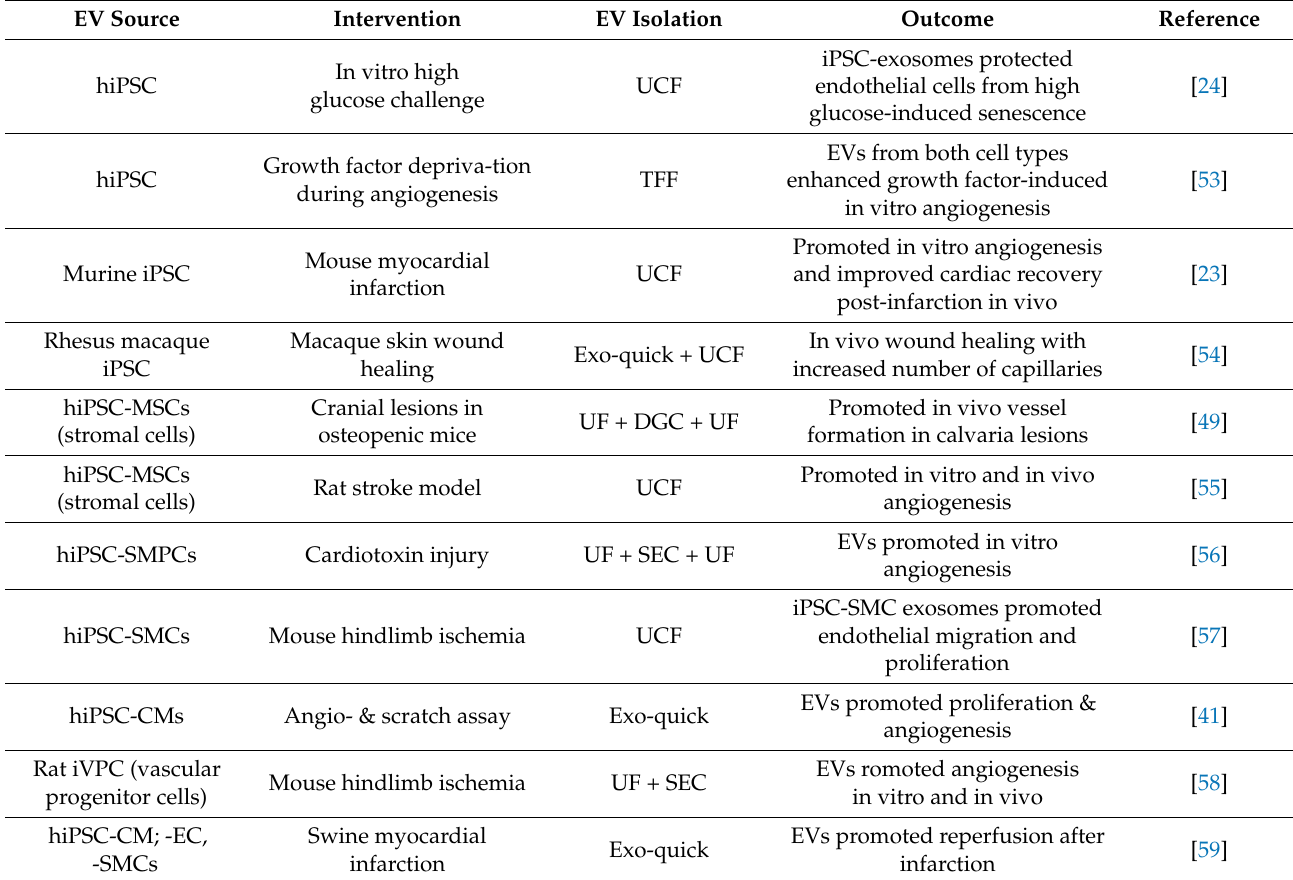
Table A1. Studies evaluating the angiogenic potential of iPSC-derived